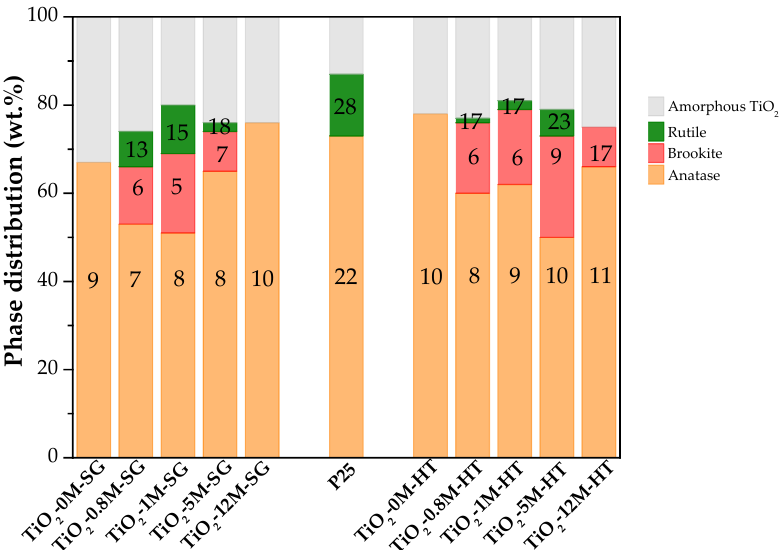
Figure 2. Distribution of crystalline and amorphous phases in TiO 2 -SG and TiO 2 -HT samples. Numbers in the figure refer to the mean crystal size (nm) of each TiO 2 crystalline phase.